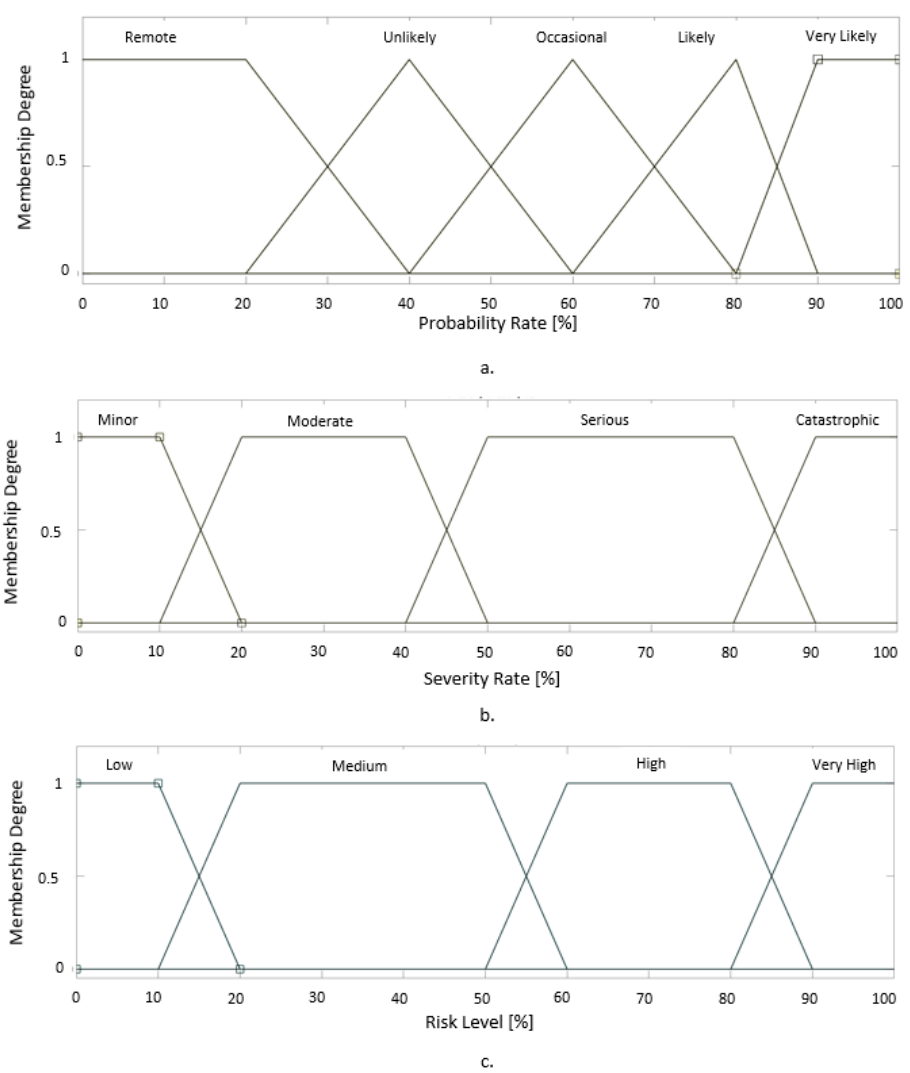
Figure 4. The structure of Mamdani FIS (Fuzzy Inference System) provided by MATLAB.